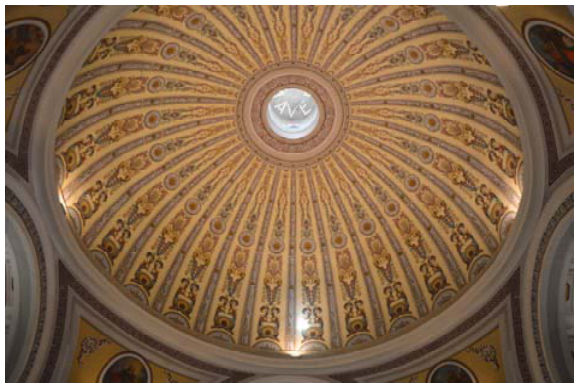
Figure 6: The dome